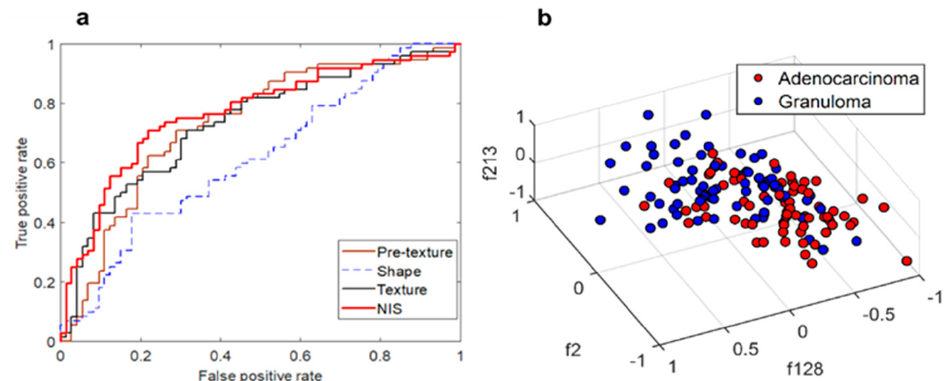
Figure 4. The performance of NIS features in supervised and unsupervised learning settings. ( a ) ROC curve of classifiers trained with NIS and other radiomic features in S v . ( b ) Nodules represented in the space of top 3 NIS features. As figure suggests, two classes of nodules within top 3 discriminating NIS features appear to be separable.